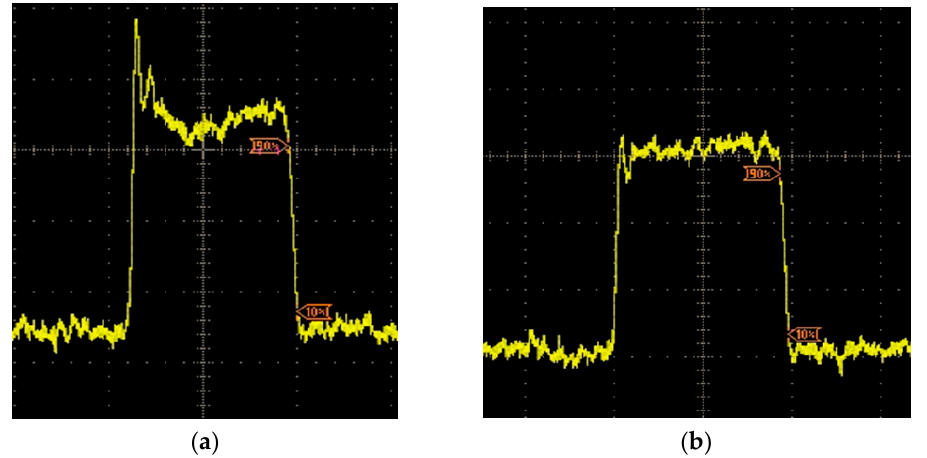
Figure 11. Far-field pattern of the SS-VCSEL on the Tx module at different temperatures under ( a ) one-block and ( b ) all-blocks emissions.